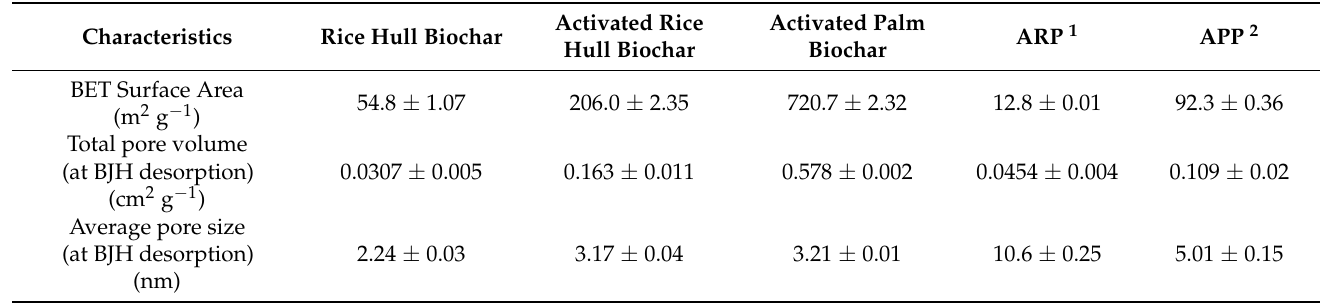
Table 3. BET result of rice hull biochar, activated rice hull biochar, activated palm biochar, and their manure-compost pellet materials.